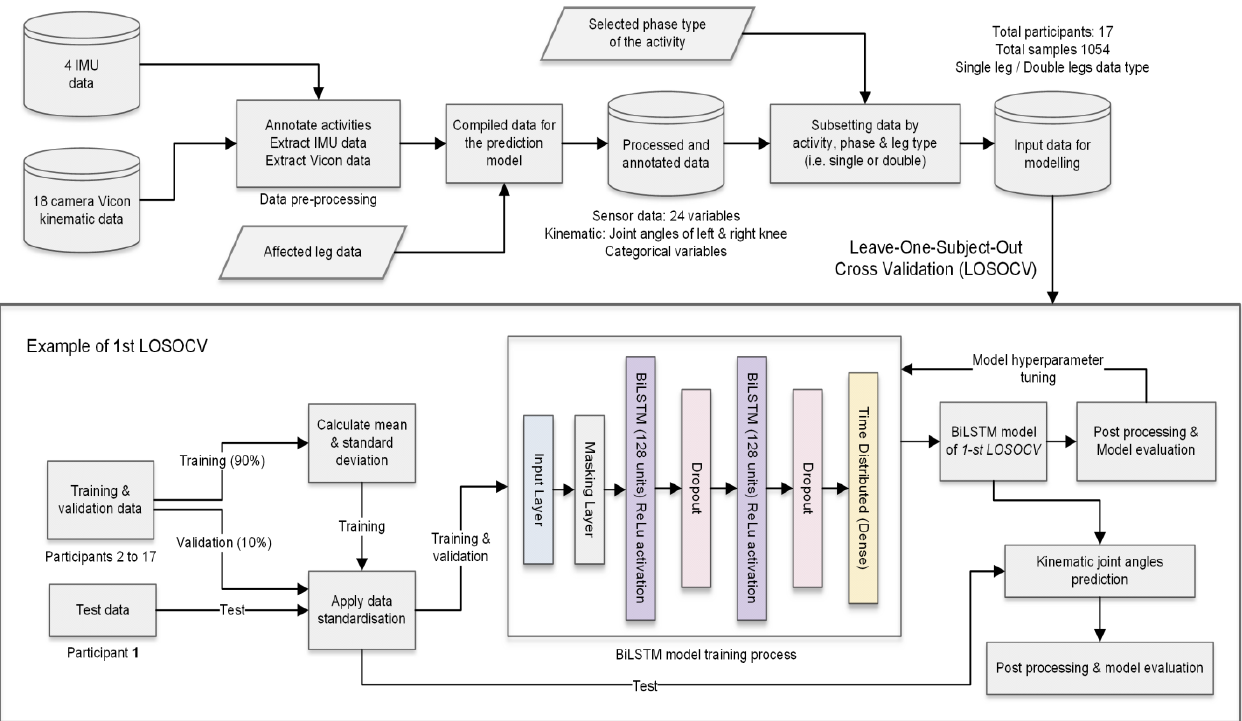
Figure 2. Data preparation and model architecture of the proposed BiLSTM kinematic prediction models.